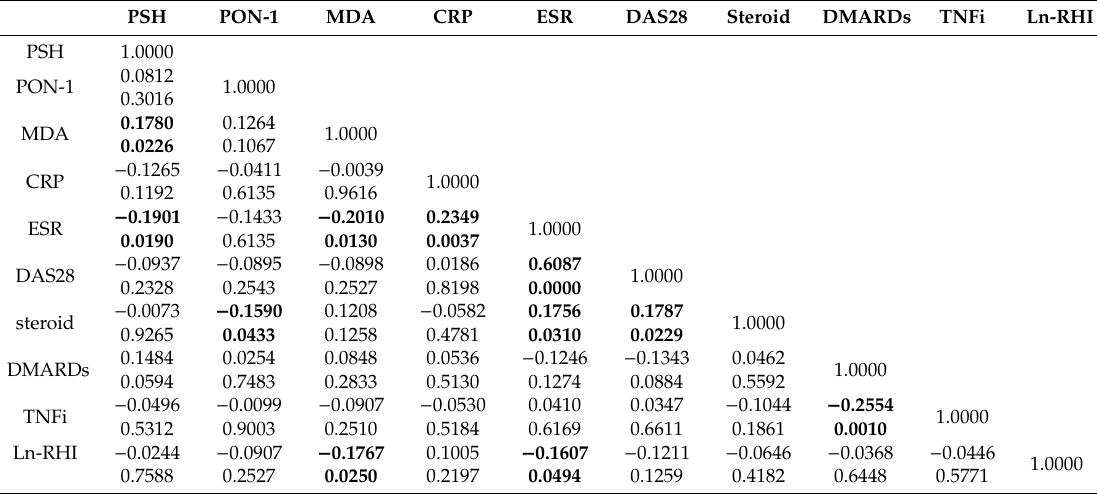
Table 4. Correlation matrix between plasma oxidative stress biomarkers and RA features.